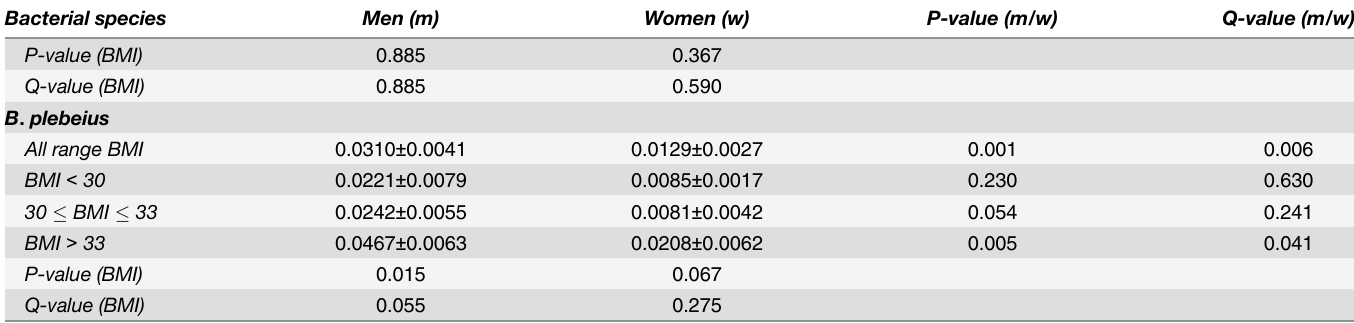
BMI: body mass index. Rows : comparison of the abundance of the different bacterial species between men and women with different BMI range or all BMI ranges together by the Mann-Whitney U test. Columns : comparison of the abundance of the different bacterial species between different BMI ranges in men and women separately by the Kruskal-Wallis test. Q-value : False Discovery Rate (FDR) using Benjamini and Hochberg